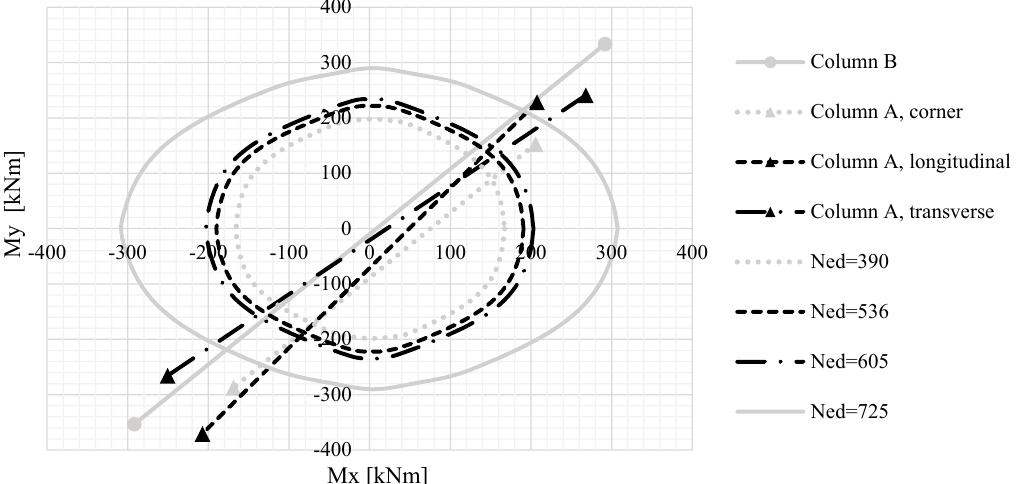
Figure 11. Resistance domains for columns of the static scheme with rigid joints.